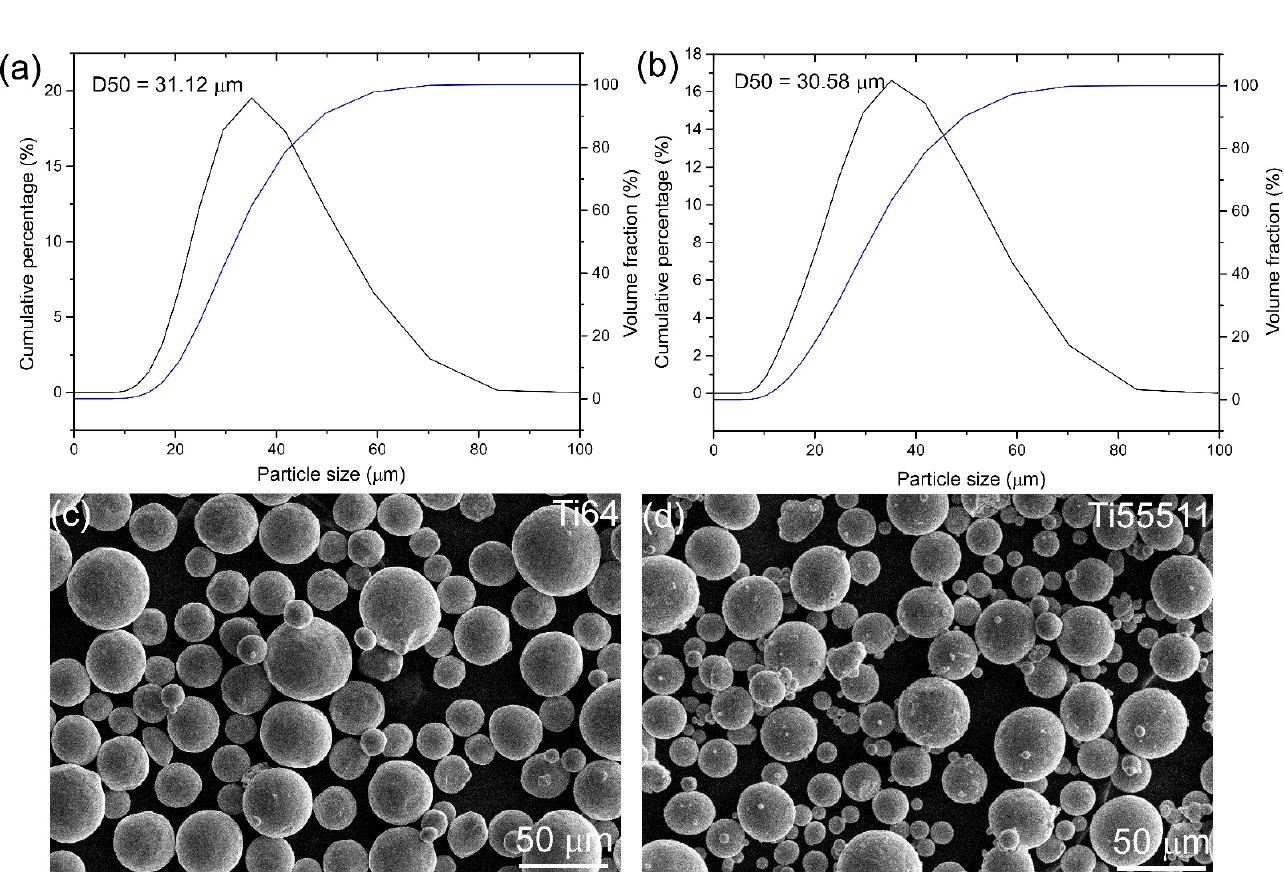
Figure 1. Particle size distribution of ( a ) Ti64 and ( b ) Ti55511. SEM images showing the morphology of powder for ( c ) Ti64 and ( d ) Ti55511.